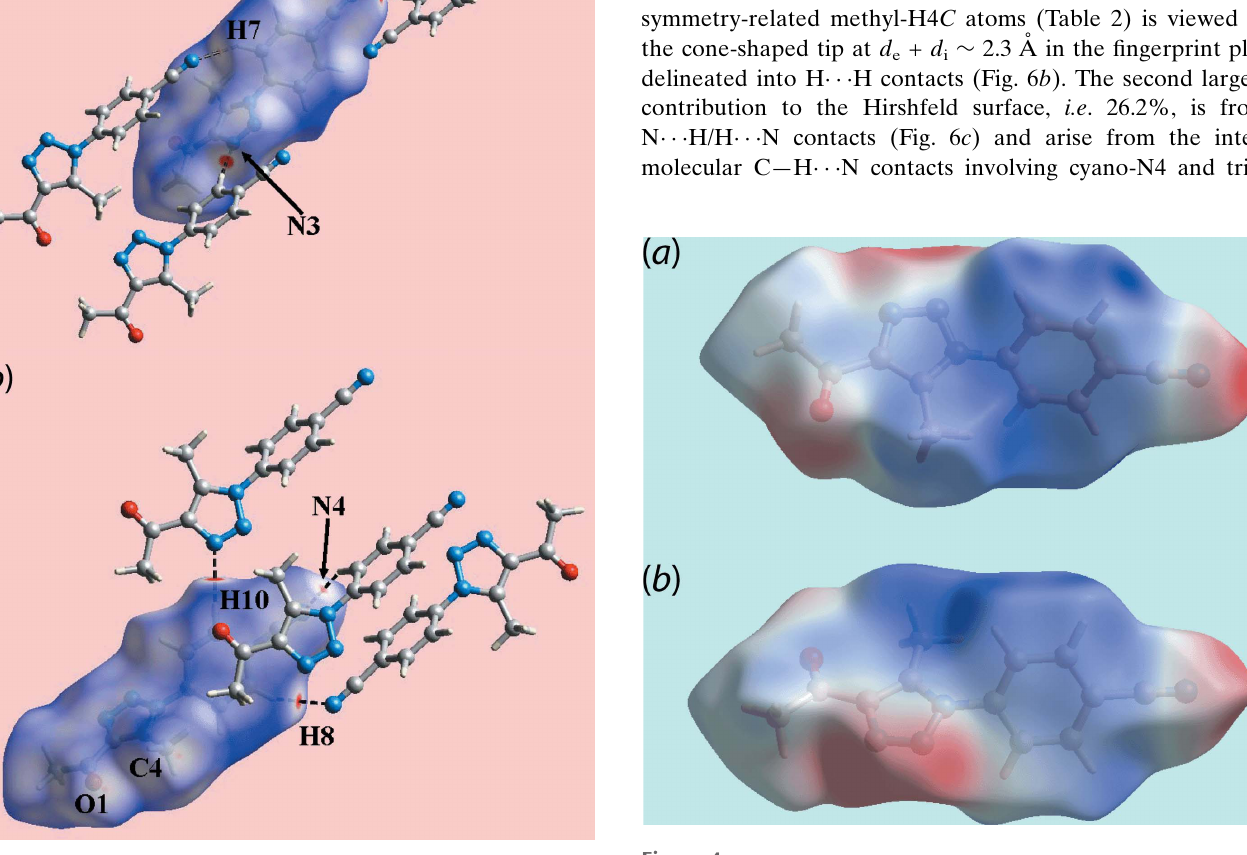
Table 3. The short interatomic H (cid:3) (cid:3) (cid:3) H contact involving